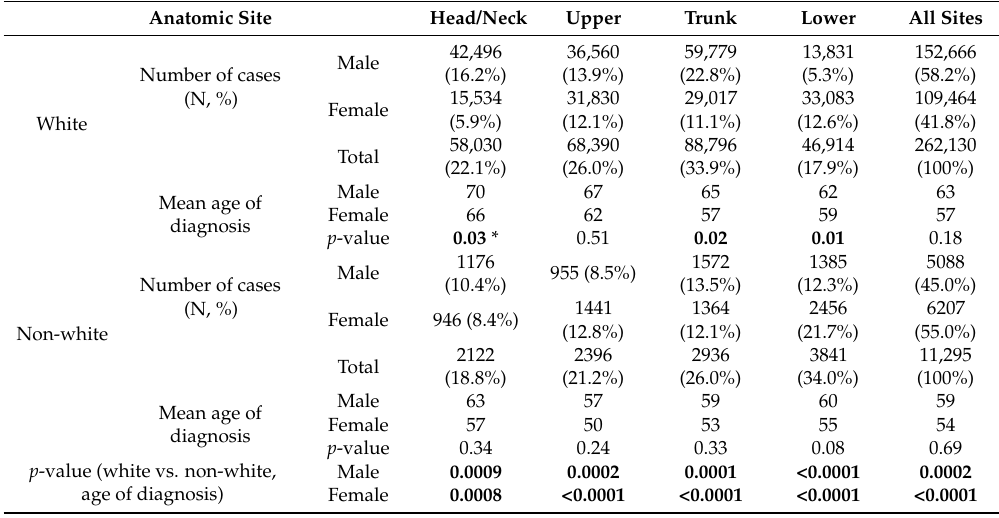
Table 1. Cutaneous melanoma patient characteristics of the SEER18 database